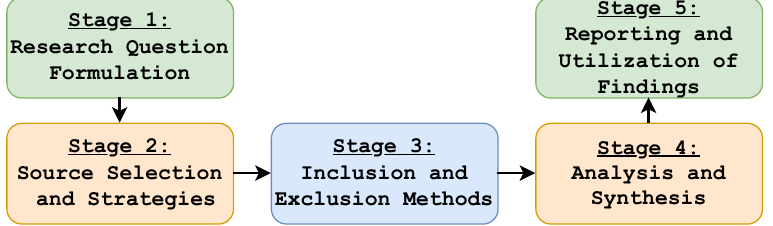
Figure 4. Research methodology adopted in the current study